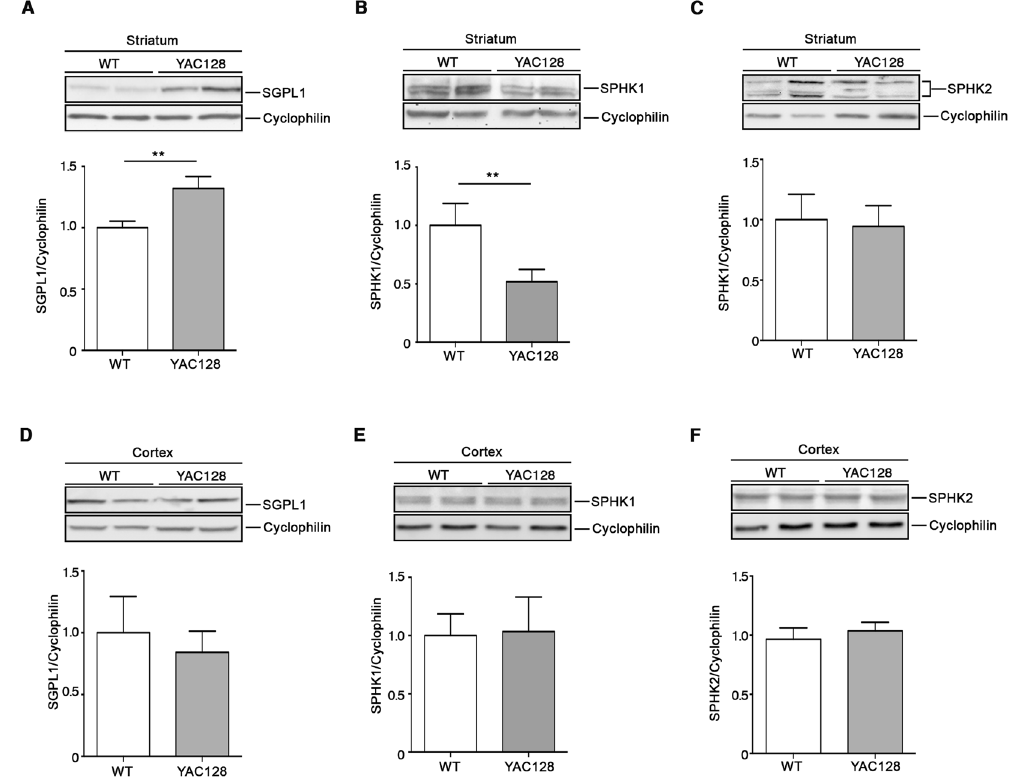
Figure 3. Expression of S1P-metabolizing enzymes is defective in the striatum of YAC128 HD mice. Representative cropped immunoblottings and densitometric analysis of SGPL1 and SPHK1/2 isoform expression in striatal ( A–C ) and cortical ( D,E ) tissues from manifest (9 month old) YAC128 mice and WT littermates. Value are represented as mean ± SD. N = 5 for each group of mice. * p < 0.05; ** p < 0.001 (Unpaired